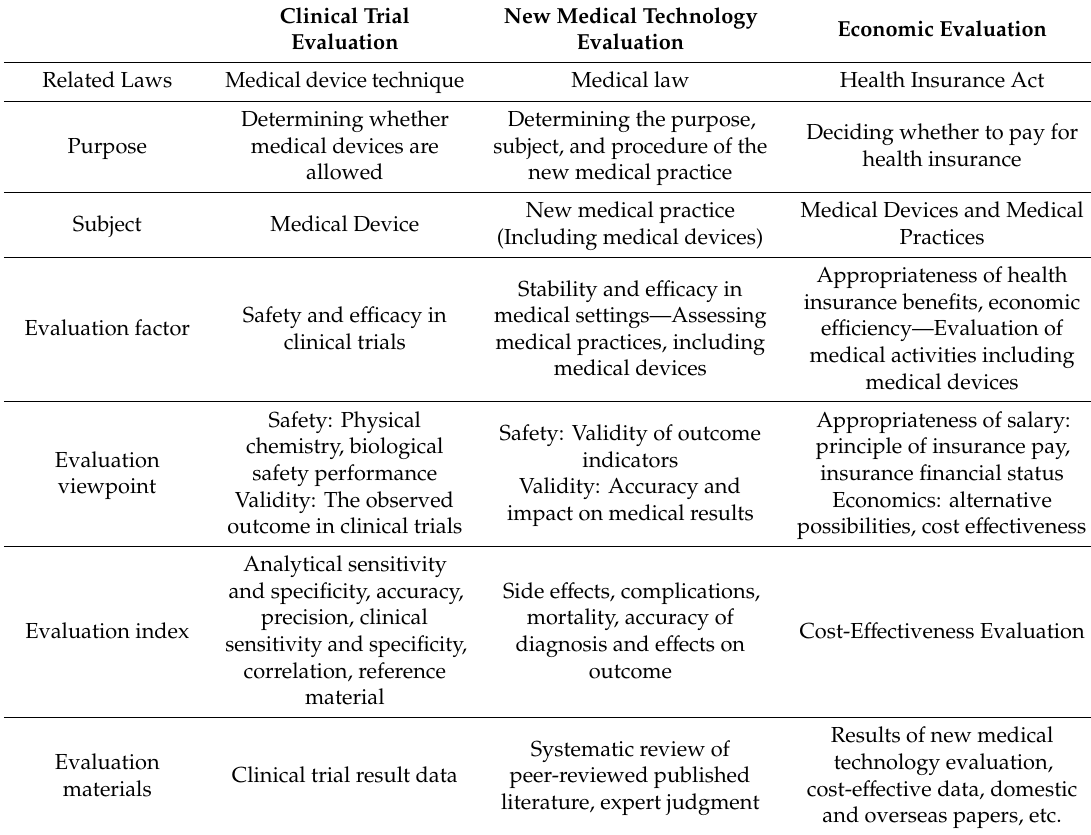
Table 1. Evaluations at the clinical trials and regulatory decision stages.